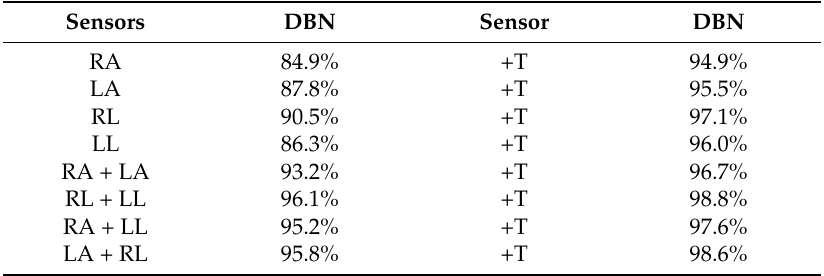
Table 7. Correct differentiation rates of sensor units at different positions.